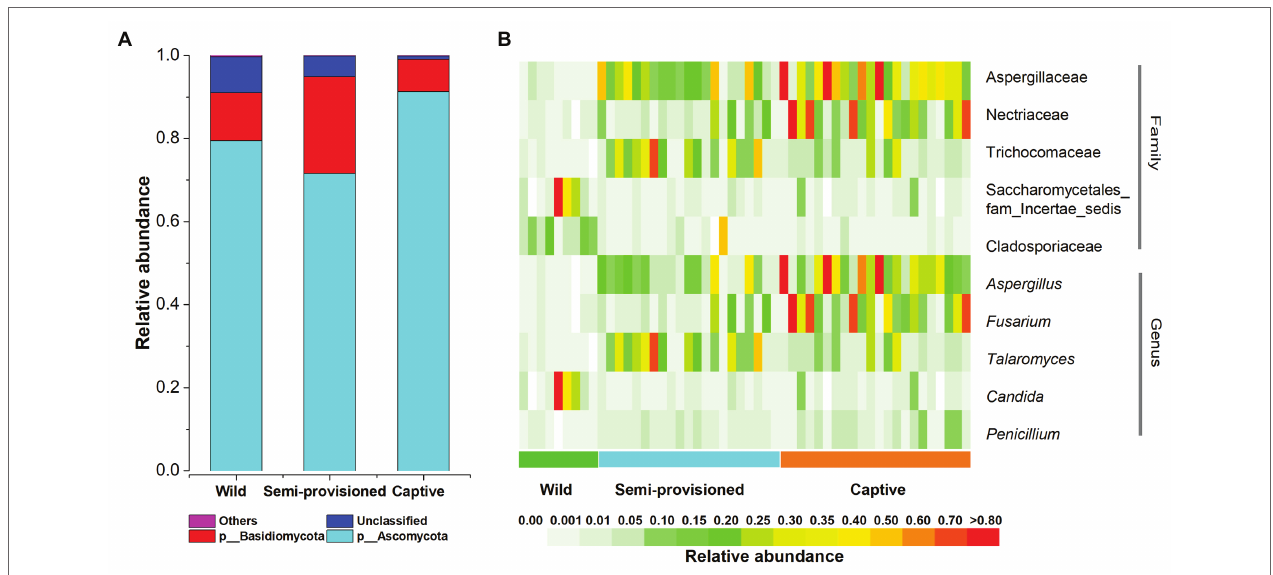
FIGURE 1 | The distributions of phylum, families, and genera. (A) Relative abundance of fecal fungal taxa at the phylum level. Stacked bar graphs illustrate the abundances of phyla, and the x -axis represents the sample groups. (B) The distributions of core families and genera (average relative abundance >0.01, present in more than 90% of all fecal